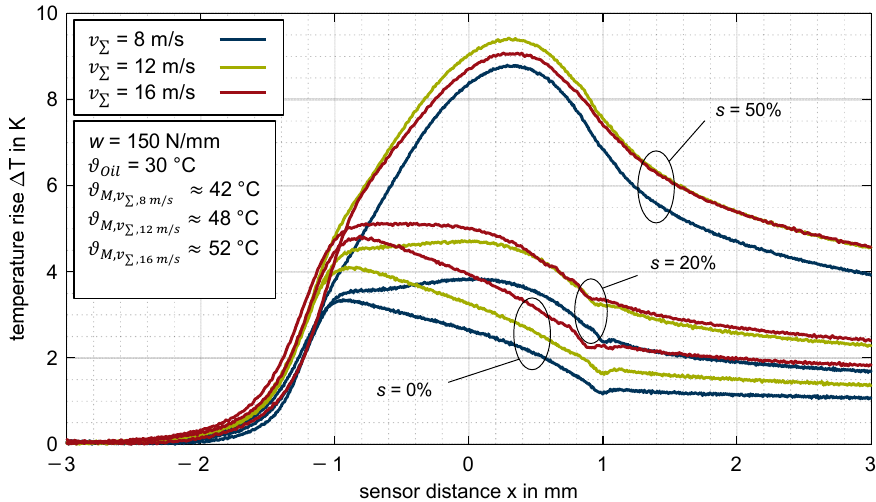
Figure 10. Temperature rise ∆ T for different sum velocities v ∑ = {8; 12; 16} m/s for the thermoplastic EHL contact ZrO 2 /PEEK (slip ratio s = {0; 20; 50}%, line load w = 150 N/mm, oil temperature ϑ oil = 30 ◦ C, MIN100). For pure rolling with s = 0%, ∆𝑇 (cid:3040)(cid:3028)(cid:3051) in the contact inlet zone increases from 3.4 K for v Σ = 8 m/s to 4.8 K for v Σ = 16 m/s. After reaching the maximum temperature rise, the